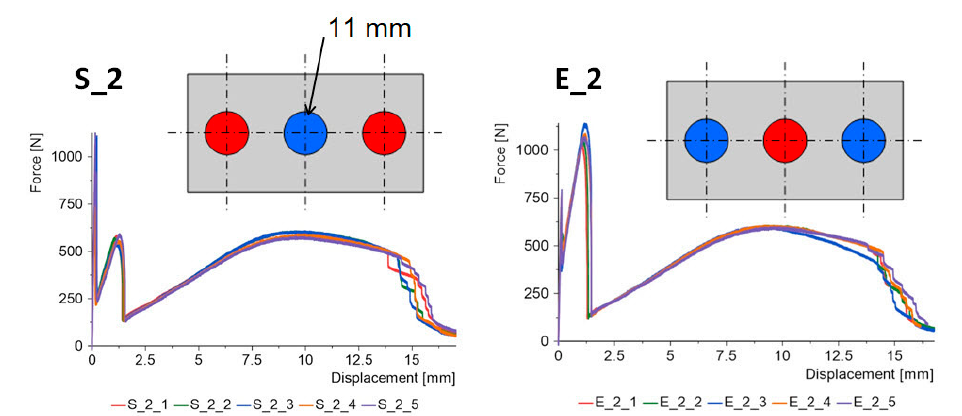
Figure 8. Triple-adhesive samples, batch 2.